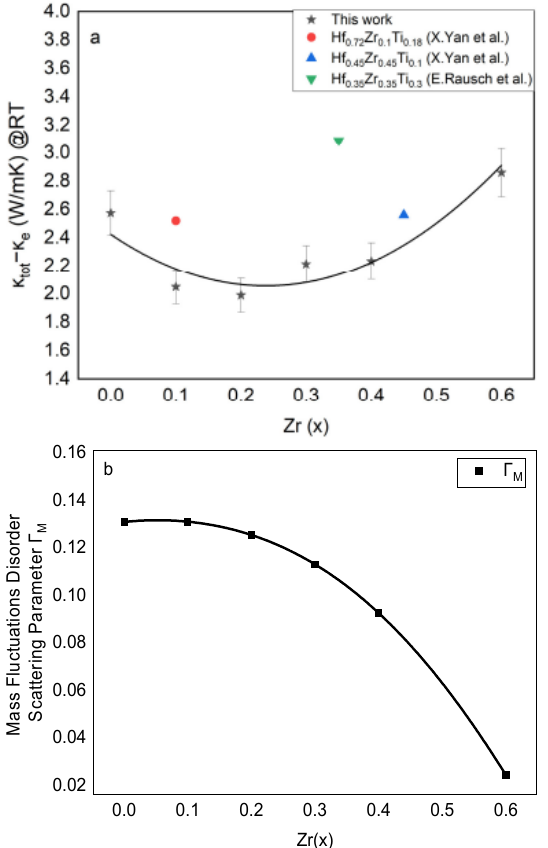
Figure 5. The lattice thermal conductivity at room temperature (the line is guide to the eye) ( a ) and the theoretical disorder scattering parameter due to mass fluctuations Γ M as function of Zr concentration ( b